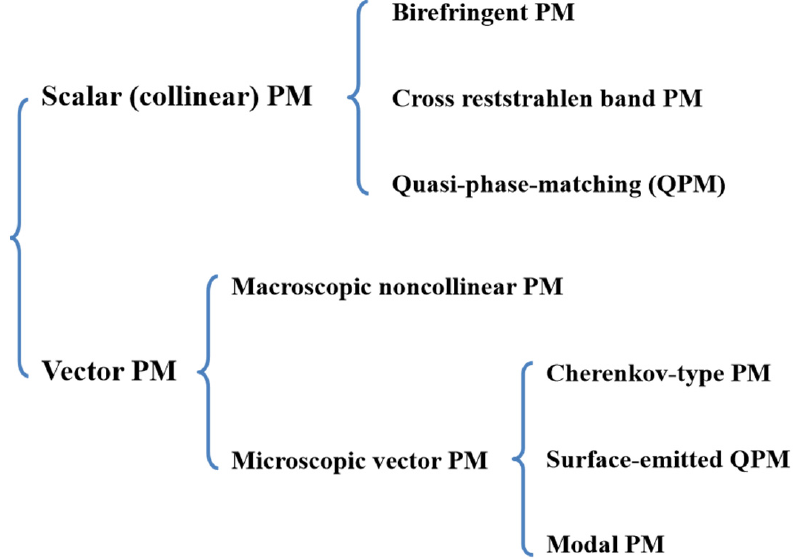
Figure 1. Classification of phase-matching in nonlinear THz-wave generation.